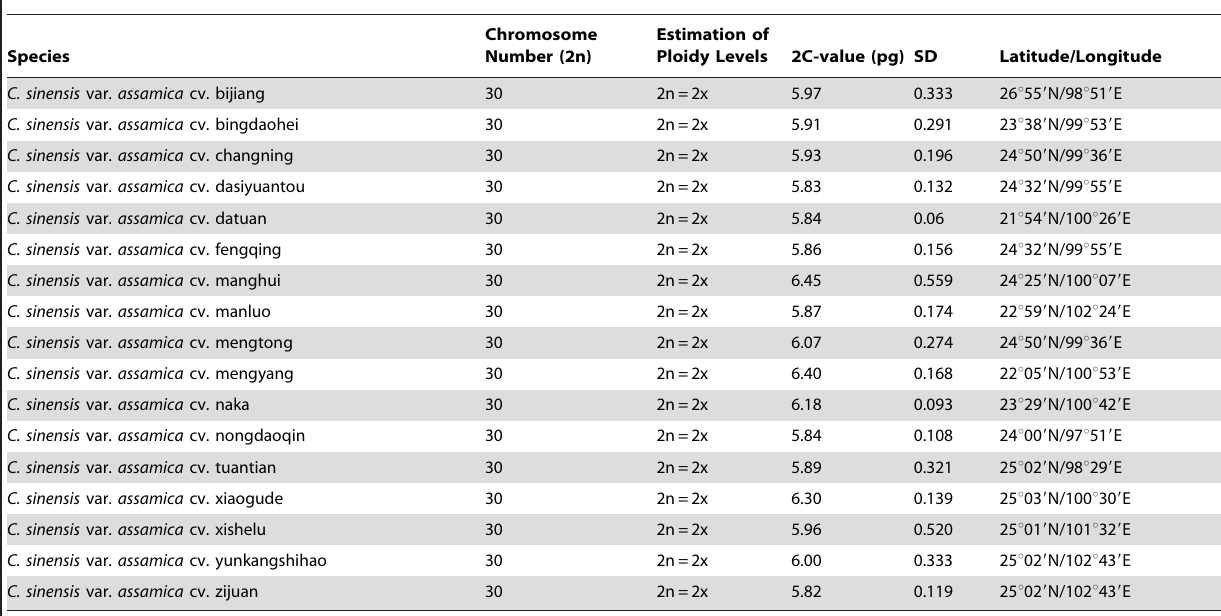
Table 2. Nuclear DNA amount of C. sinensis var. assamica cultivars estimated with flow cytometry.